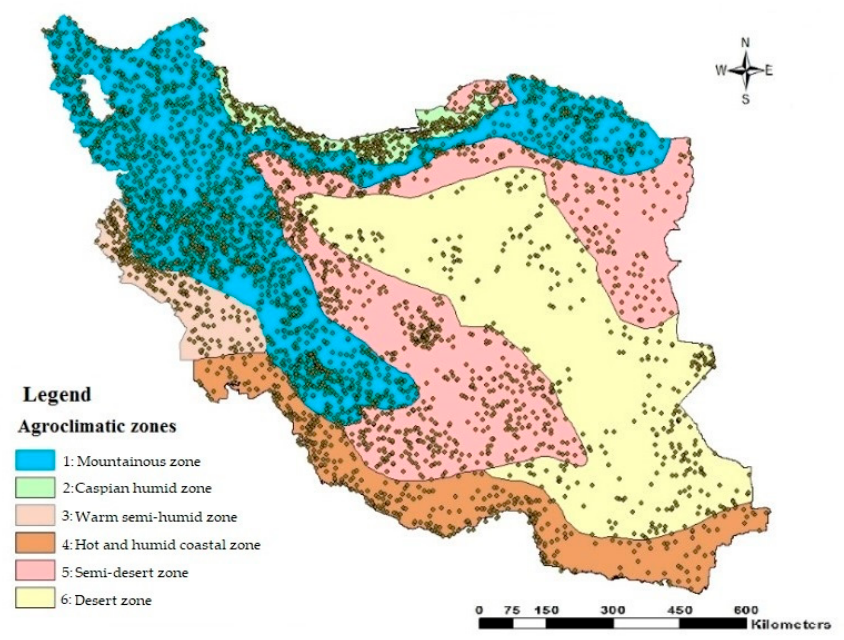
Figure 2. Location of the meteorological stations and agro-climatic zones in Iran.